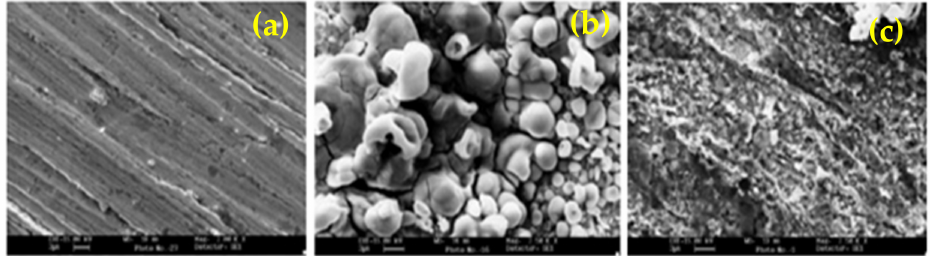
Figure 11. Scanning electron micrographs for: ( a ) polished mild steel, ( b ) mild steel in 20% formic acid and ( c ) mild steel in 20% formic acid +100 ppm APT